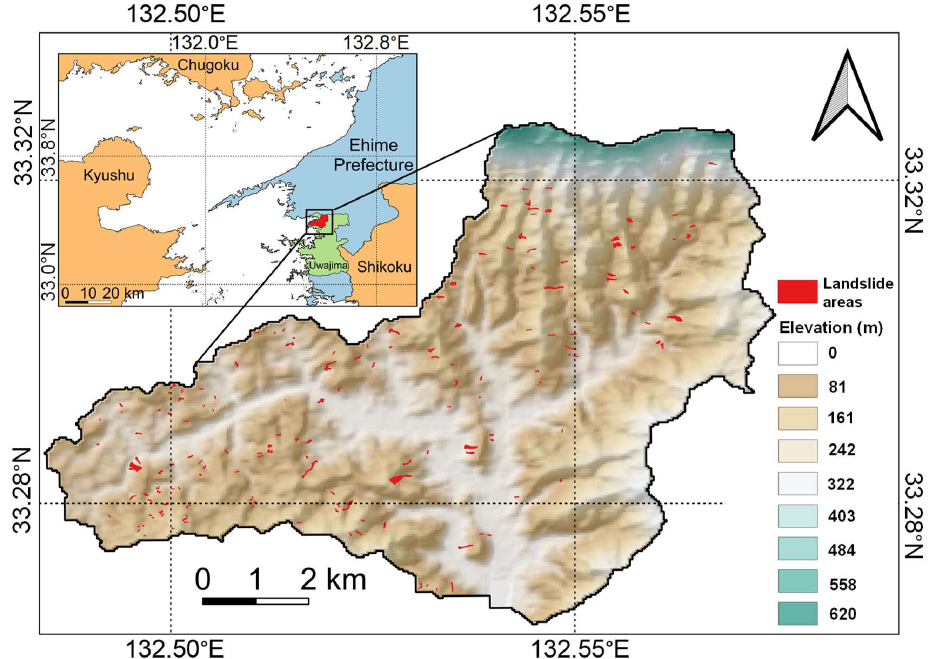
Figure 1. Location of the study area (in Uwajima City, southwest part of Ehime prefecture) and landslide distribution in July 2018. The height of elevation means height above sea level. Heavy rainfall events occurred from 1 to 8 July 2018. At the Uwajima station, the total rainfall was 578.0 mm; the maximum hourly rainfall observed from 06:00 to 07:00 on 7 July was 49.0 mm (Figure 2). The rainfall event induced numerous landslides in several cities in Ehime prefecture, particularly in Uwajima City. Uwajima City suffered the greatest landslide disaster on 7 July 2018; in total, 51 debris flows and 102 steep slope failures affected houses and public facilities [26].